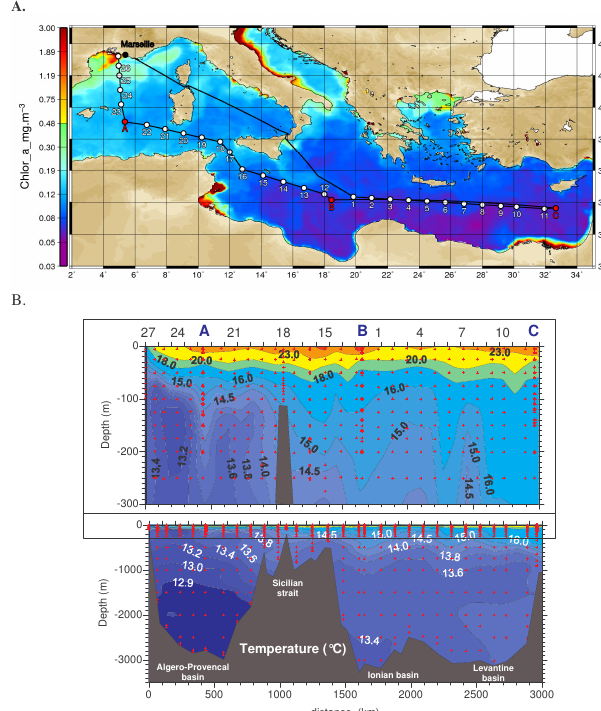
Figure 1A. Map of the BOUM cruise transect (16 June - 20 July 2008) in the Mediterranean Sea 5 Fig. 1. (A) Map of the BOUM cruise transect (16 June–20 July superimposed on a SeaWiFS composite image of the sea surface chlorophyll a concentration 6 2008) in the Mediterranean Sea superimposed on a SeaWiFS com- (courtesy to E. Bosc). "Short duration" stations are regularly distributed and numbered from 1 to 27. 7 posite image of the sea surface chlorophyll- a concentration (cour- The 3 "long duration (4 days)" stations A, B, and C in the western, Ionian and Levantine basins 8 tesy to E. Bosc). “Short duration” stations are regularly distributed respectively are located near the centre of an anticyclonic eddy. B. Vertical sections of 9 and numbered from 1 to 27. The 3 “long duration (4 days)” stations temperature (°C) over the whole water column (bottom) and a zoom for surface (0-300 m; 10 A, B, and C in the western, Ionian and Levantine basins respectively top). On the top X-axis, the position of the stations is indicated. 11 are located near the centre of an anticyclonic eddy. (B) Vertical sec- tions of temperature ( ◦ C) over the whole water column (bottom) and a zoom for surface (0–300m; top). On the top x-axis, the position of the stations is